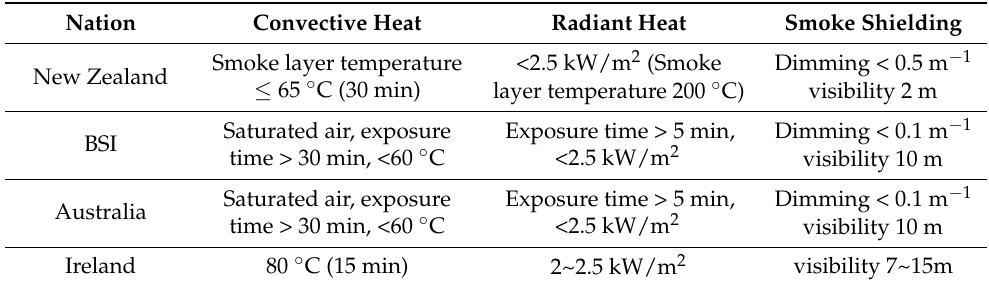
Table 1. Standards for human life safety